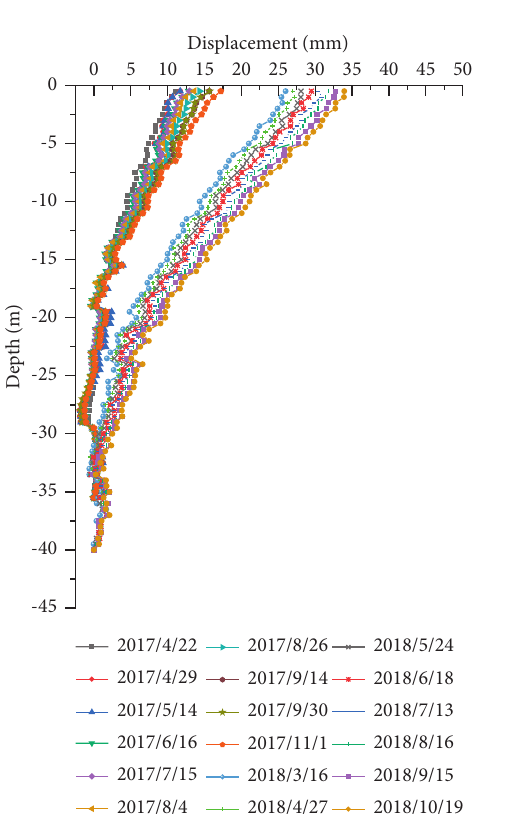
Figure 5: Displacement curve of 29# antislide pile at different depths during the rainy season.